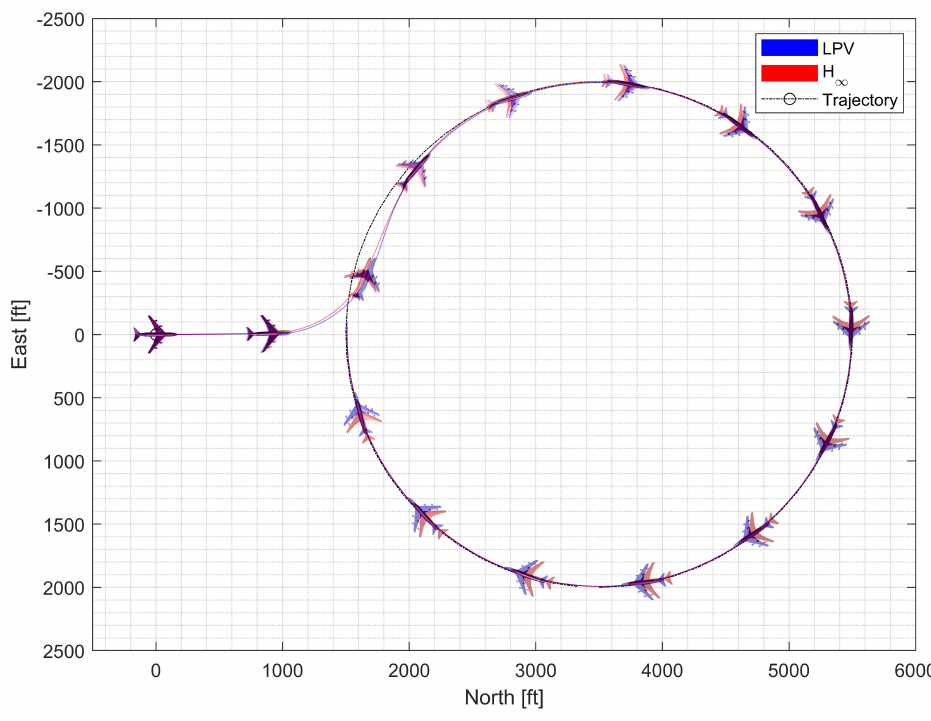
Figure 23. Flight trajectory of the circular trajectory-following flight.